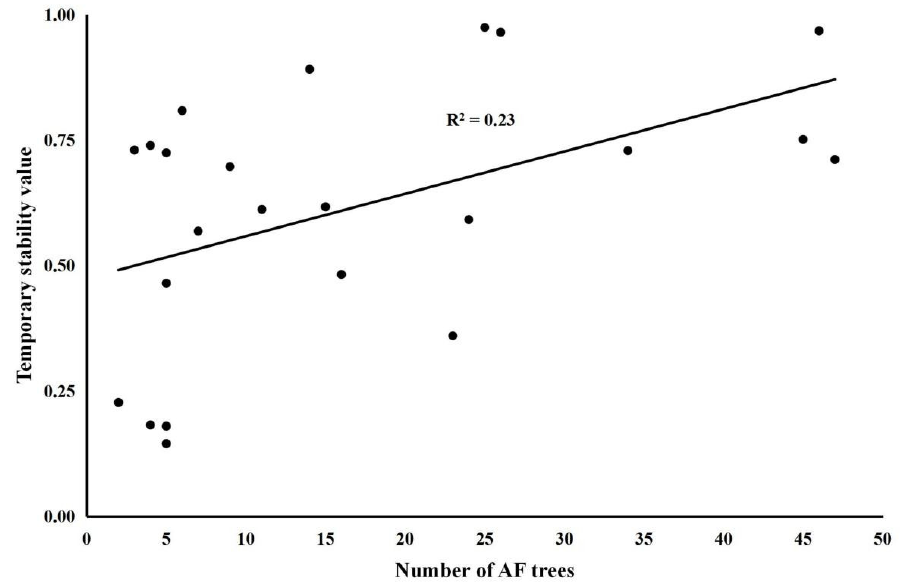
Figure 3. Scatter picture between temporary stability (TS) and the number of Abies faxoniana (AF) trees.